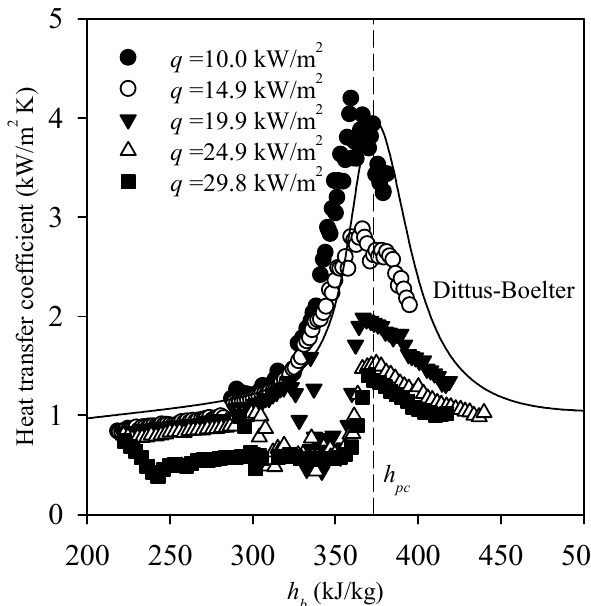
Figure 2. The comparison of experimental data for R-22 and Dittus-Boelter correlation [5], where h b and h pc signify bulk enthalpy and the enthalpy at the pseudo-critical point,